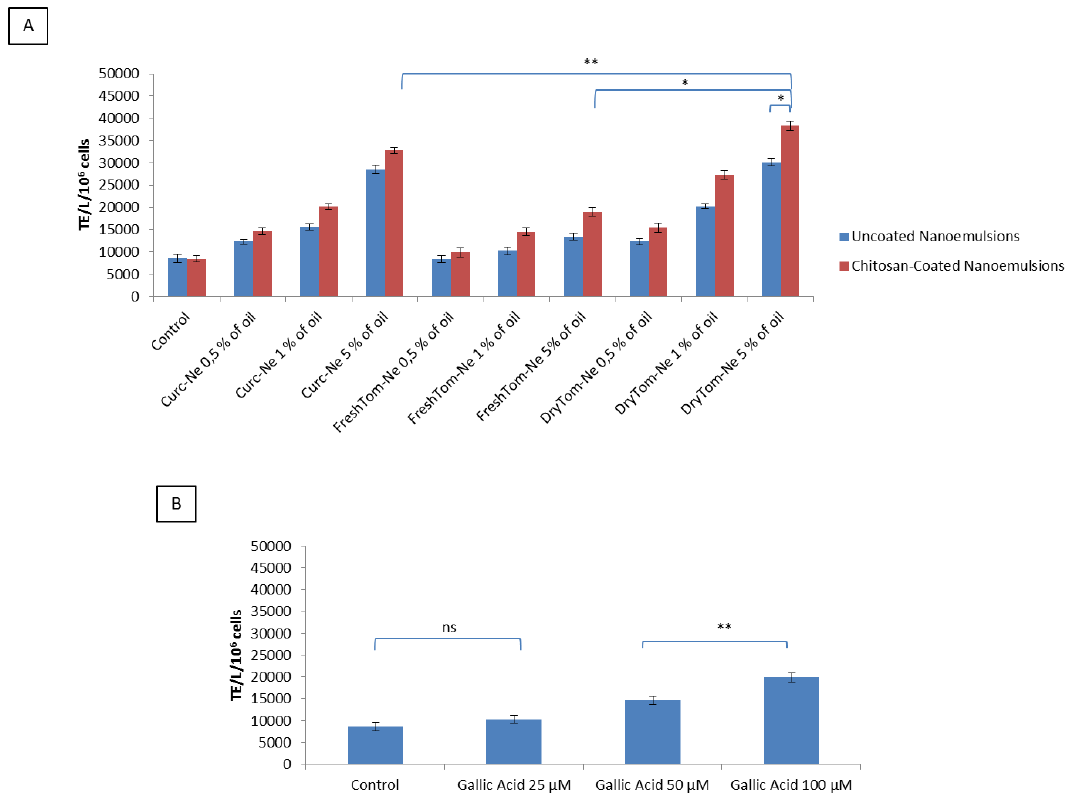
Figure 5. Mean antioxidant values ( ± SEM) of H9c2 cell lysates (TE/L/10 6 cells). Antioxidant values of cell lysates after challenge with 50 mL of AAPH (4 mM) for 10 min and recovery with PBS (control) or chitosan-coated or uncoated nutraceutical-loaded nanoemulsions ( A ) or gallic acid ( B ) at 25, 50 and 100 µ M. * p < 0.001; ** p < 0.05.